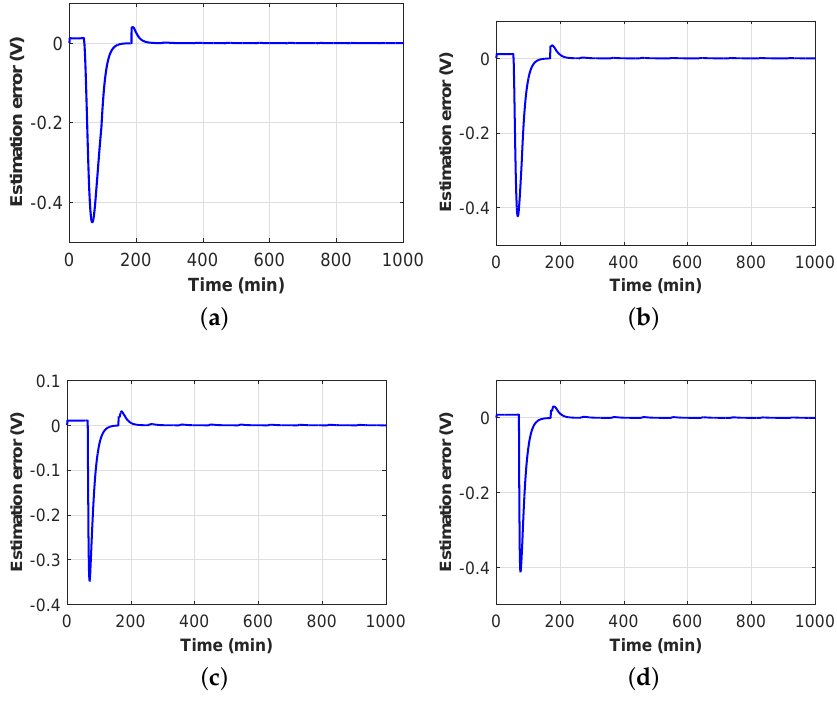
Figure 10. Relative error at different temperatures in discharge mode. ( a ) 0 ◦ C; ( b ) 10 ◦ C; ( c ) 25 ◦ C; and ( d ) 40 ◦